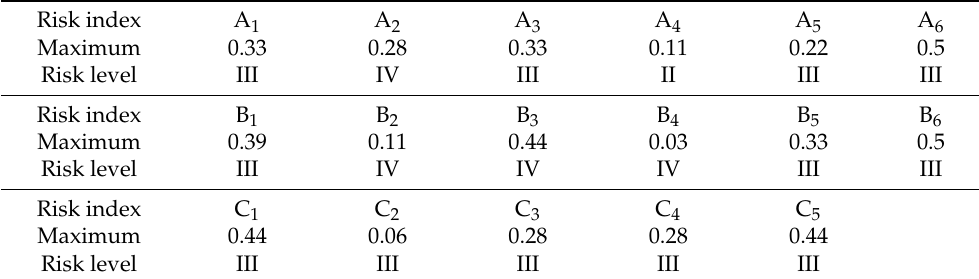
Table 6. Risk level of ICCL safety supervision